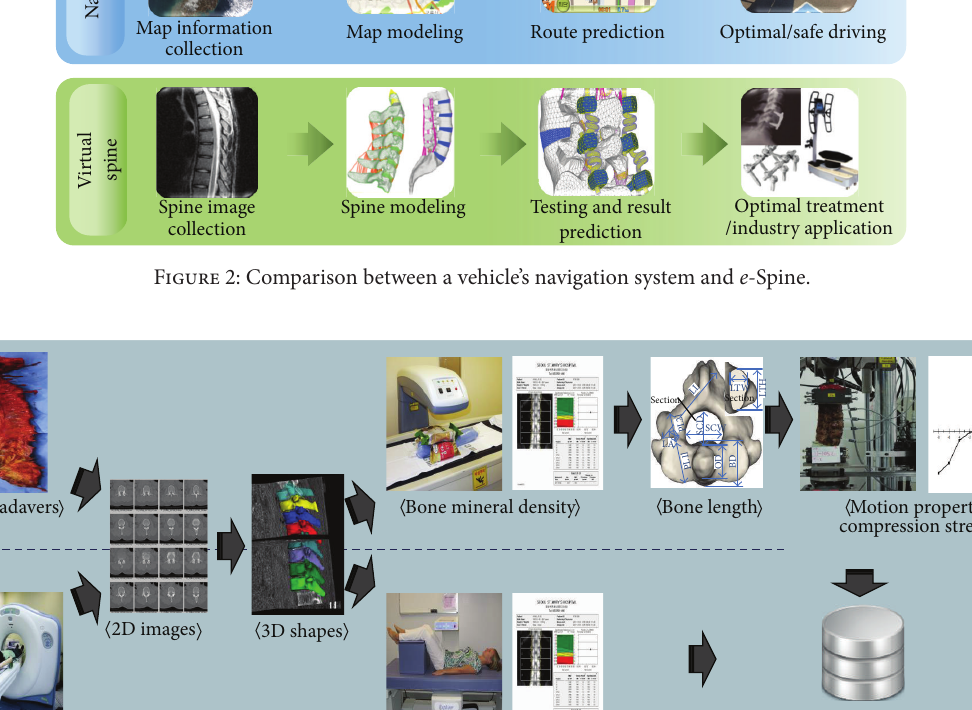
Korean spine data for degenerative spinal diseases. Figure 3 shows the process of the Korean spine database